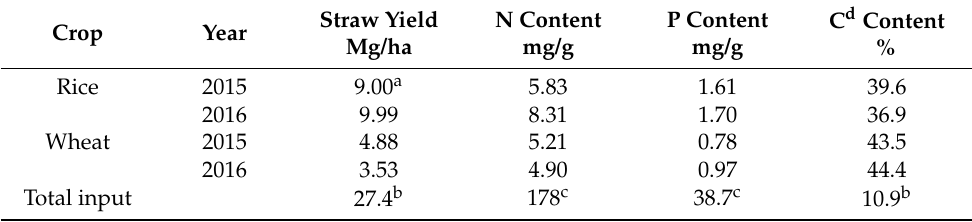
Table 1. The amount of crop straw and nutrients that was returned into the field by straw incorporation. Crop Year